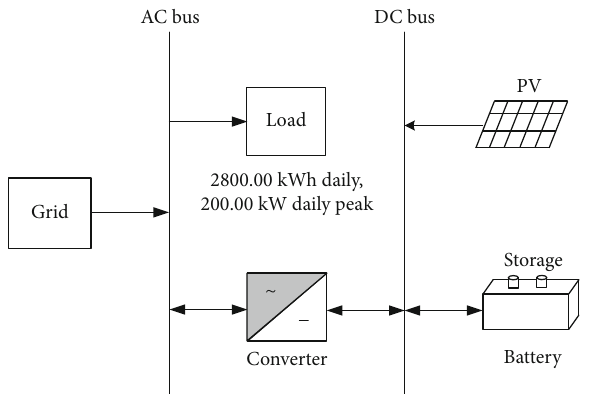
Figure 3: Schematic diagram of the HOMER